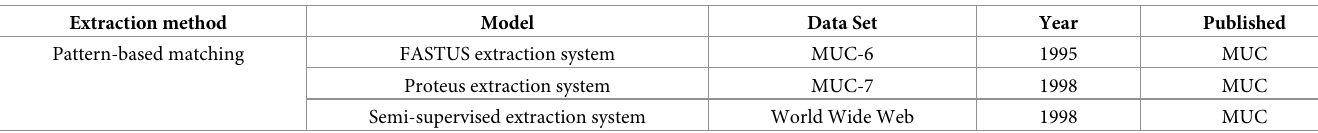
Table 1. The different models and datasets based on pattern-based